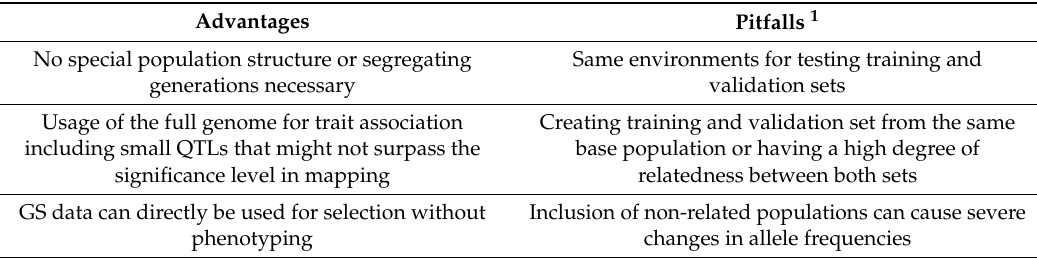
Table 1. Main advantages and pitfalls 1 for GS in science and